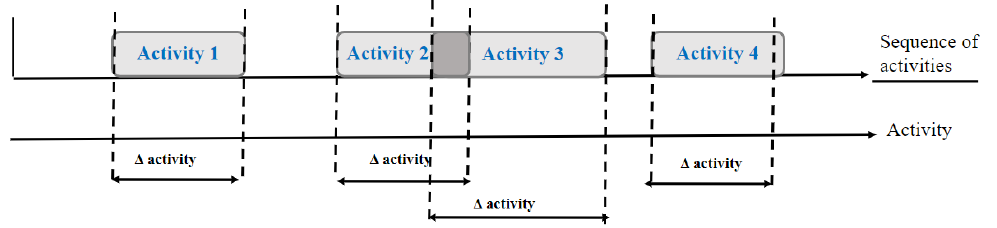
Figure 4. Drawing of the activity’s